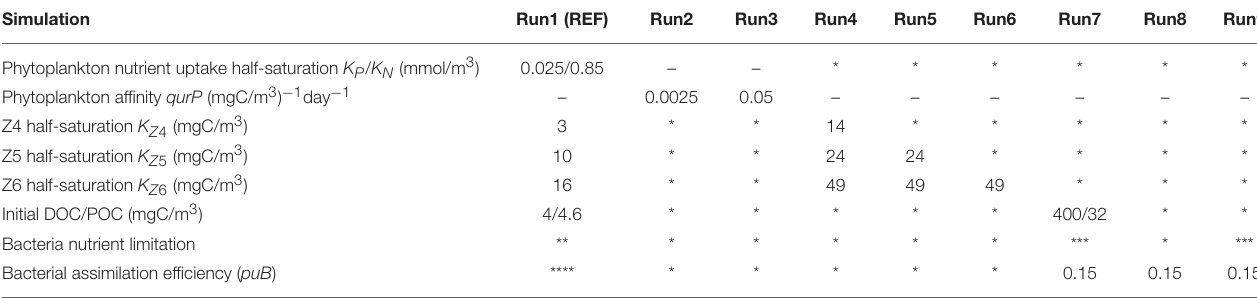
TABLE 1 | Attributes of model simulations. Simulation Run1